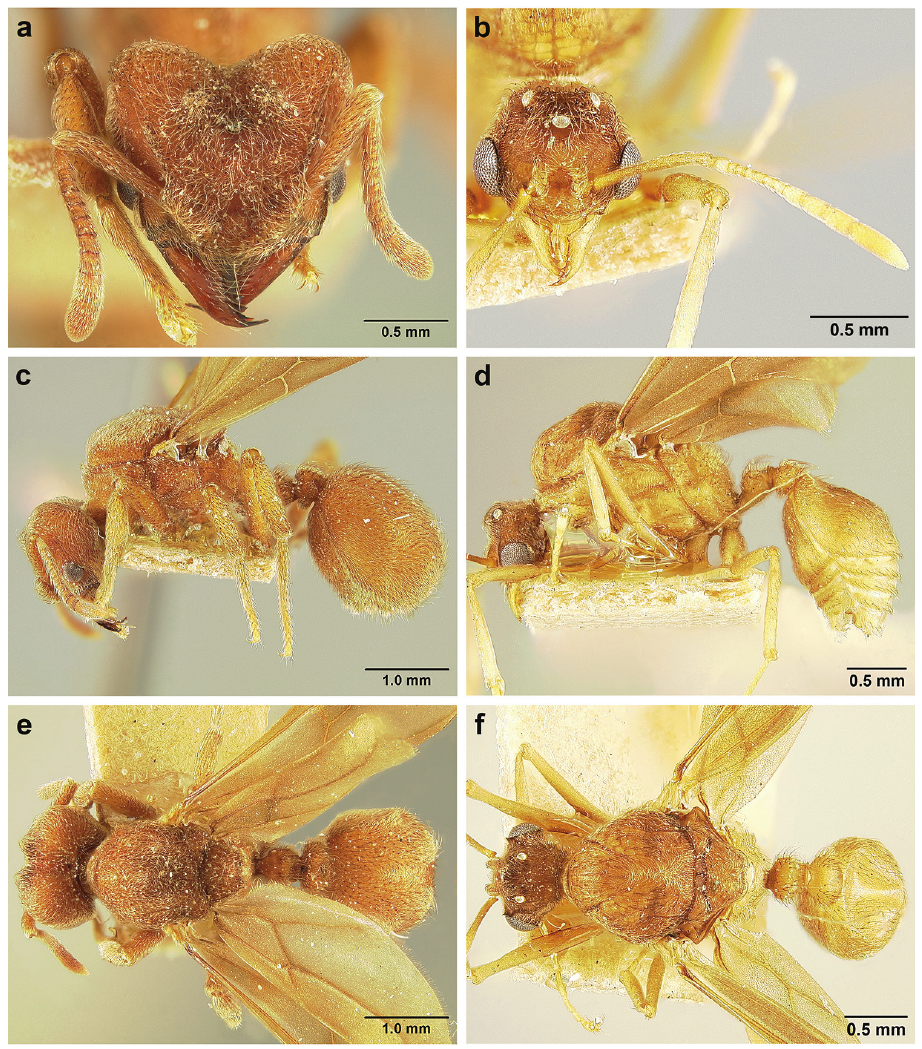
Figure 30. S. lutzi queen and male; head, lateral profile, and dorsal view. Queen (MCZ 9-11 21139) ( a, c, e ) Male (USNMENT01126226) ( b, d, f